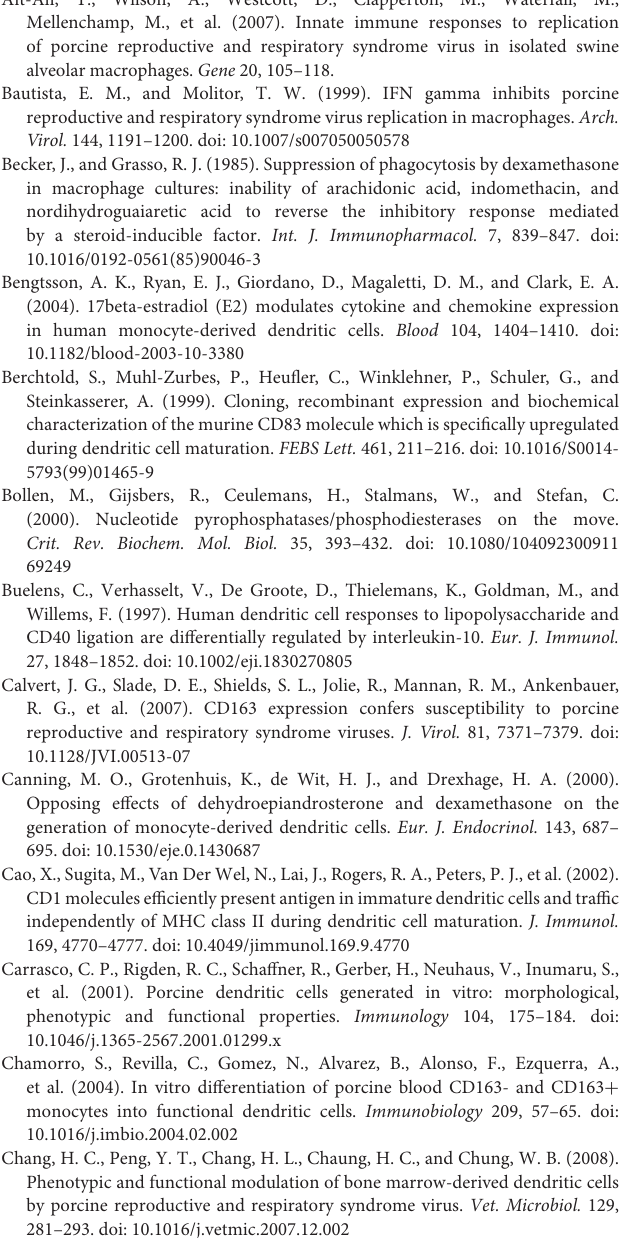
used to assess significance followed by Bonferroni’s multiple comparison test, * p < 0.05. FIGURE S6 | Intracellular PRRSV staining using SDOW-17 in MoMØ subsets. Monocytes were treated with M-CSF for 4 days to generate MoMØs, and either left unstimulated or activated with LPS and IFN- γ (M1), IL-4 (M2), dexa, or IL-10 for 24 h before infection with PRRSV Lena. At 20 h p.i cells were harvested and stained with a LIVE/DEAD Violet stain before being permeabilized and fixed for intracellular staining with α -PRRSV antibody SDOW-17 and secondary G1-APC* for detection by flow cytometry. Cells were gated on FSC/SSC (A) before dead cells were eliminated according to LIVE/DEAD Violet